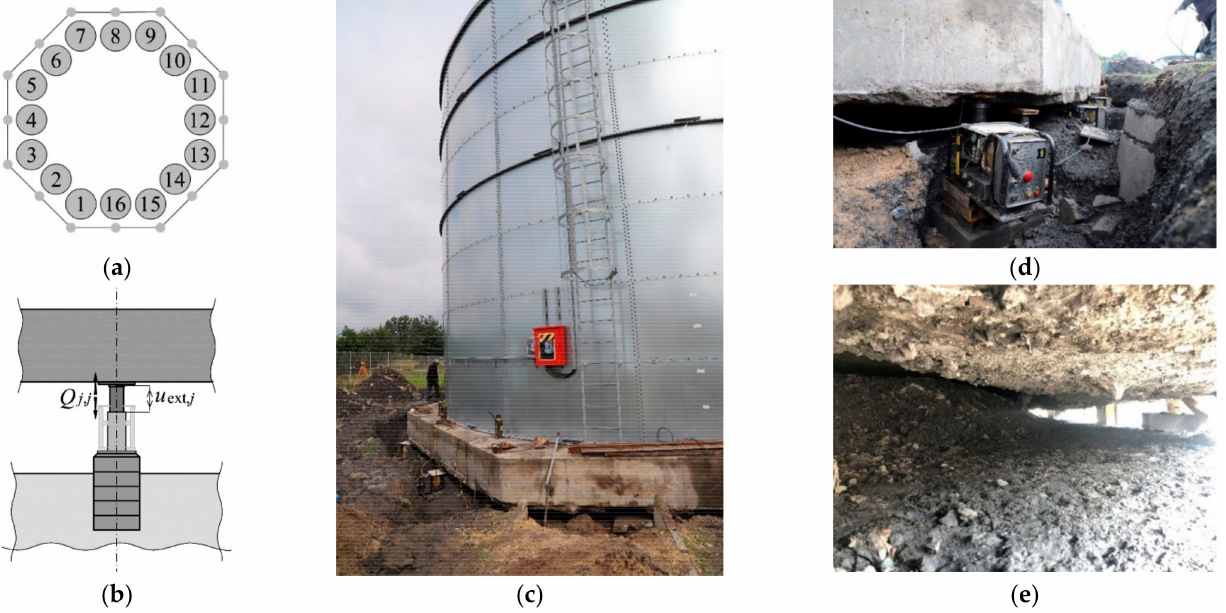
Figure 7. In-situ testing of stiffness k j , j ( j = 1, . . . , 16), ( a ) positions of the installed jacks and points of measuring the values u ext ,j and Q j,j ; ( b ) plan of measurements; ( c ) tank placed on n = 16 jacks; ( d ) jack prepared for the tests, ( e ) space formed under the foundation slab after the